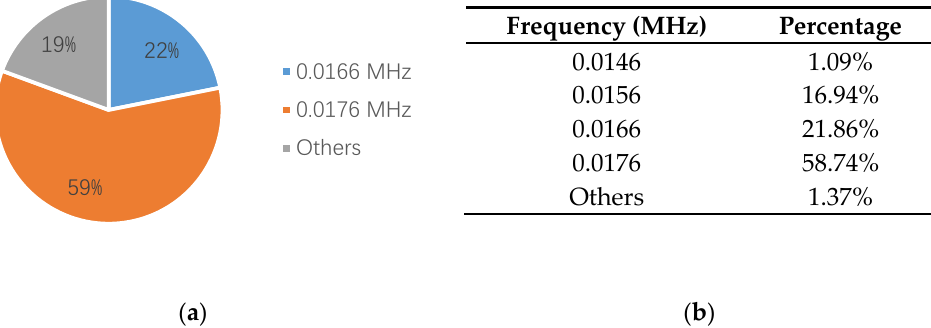
Figure 16. The frequency proportion between 0.01–0.02 MHz in the third specimen: ( a ) pie chart; ( b ) table.